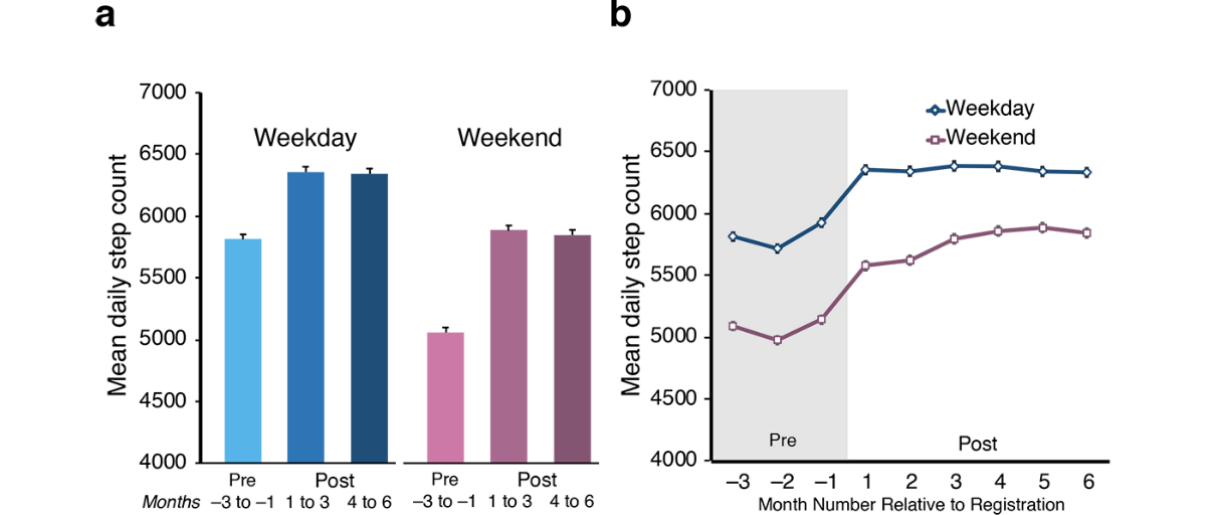
Figure 3. Mean daily step count across the sample (N=5892) was analyzed for the 3 months before app registration (Pre) and 6 months after registration (Post). (a) For analysis, these were grouped into 3-month periods; the results highlight the consistent increase in mean daily step count after registration. (b) The same measure is broken down over 30-day periods. Both plots show the data separated into weekday and weekend activity. Although weekend activity is lower, the overall pattern of increase after registration is similar. Error bars represent SE of the mean.